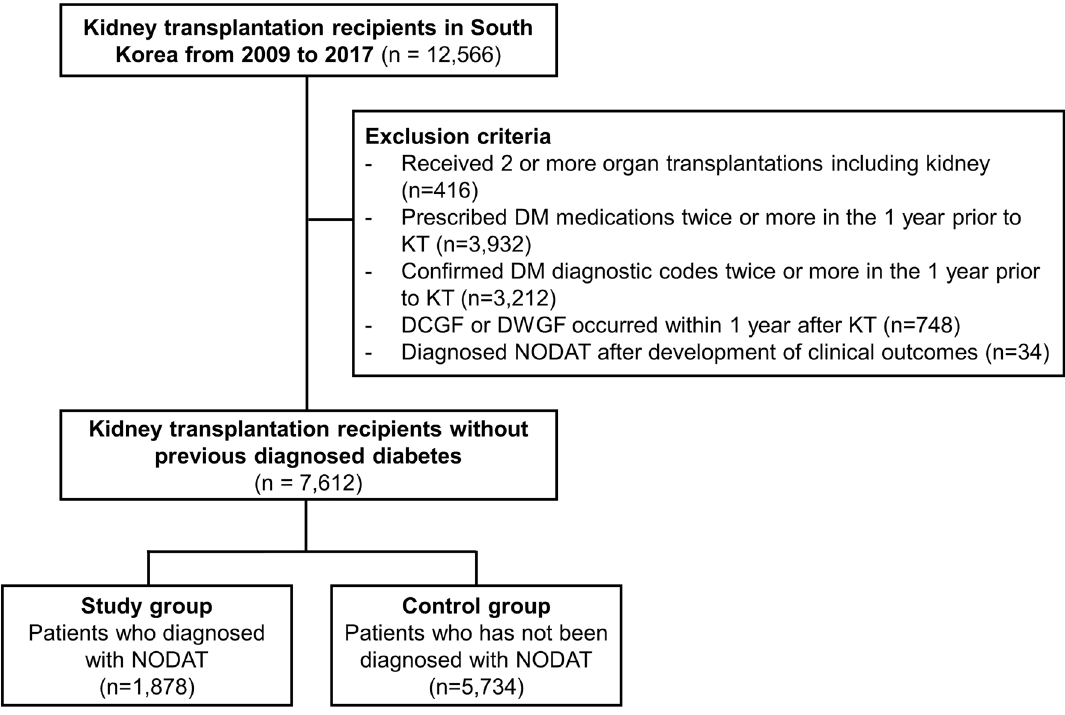
Figure 1. Flow chart of the study. DM diabetes mellitus, KT kidney transplantation, PTDM new-onset diabetes after kidney